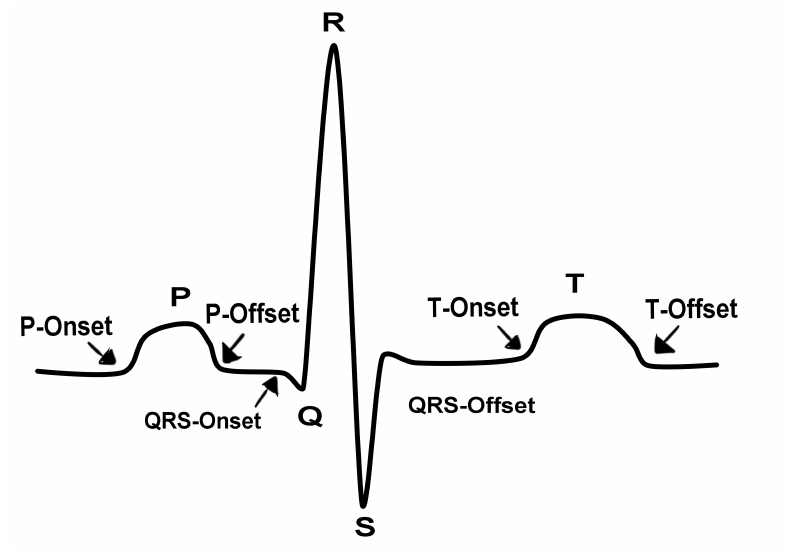
Figure 3. Example of P-QRS-T cycle, with the peaks of all the relevant